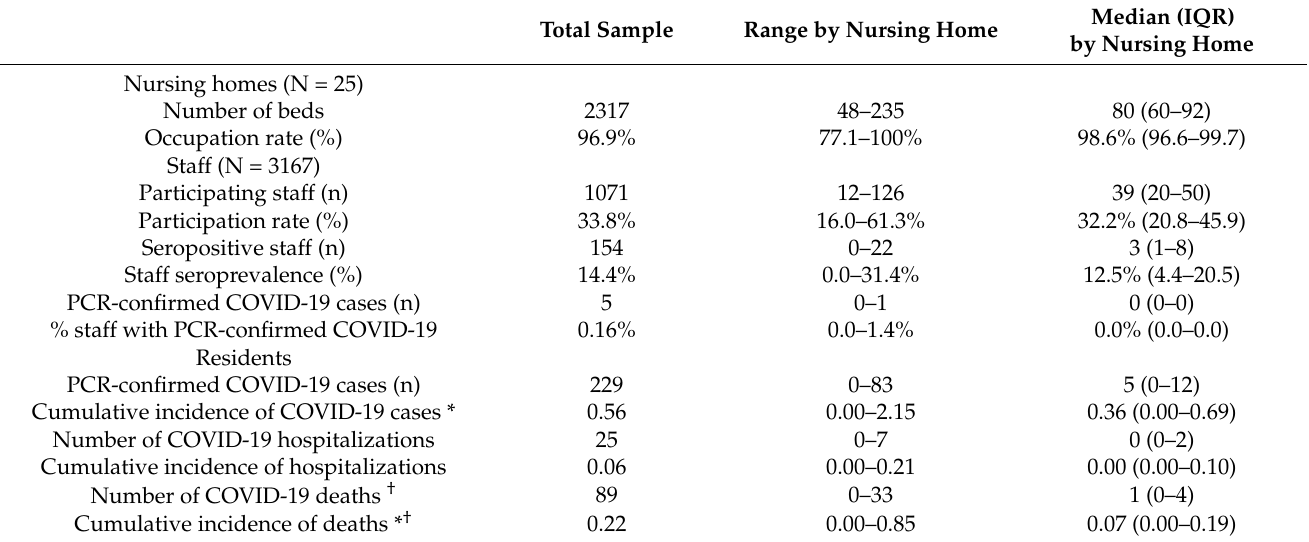
Table 1. Characteristics of nursing homes, residents, and